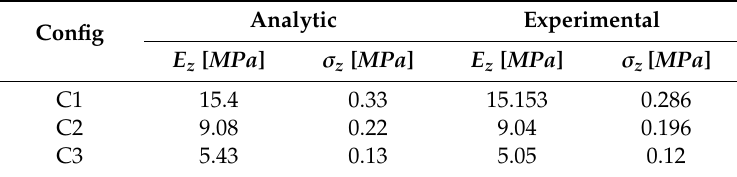
Table 3. Analytical and experimental results for the out-of-plane compression. Analytic Experimental Config E z [ MPa ] σ z [ MPa ] E z [ MPa ] σ z [ MPa ]